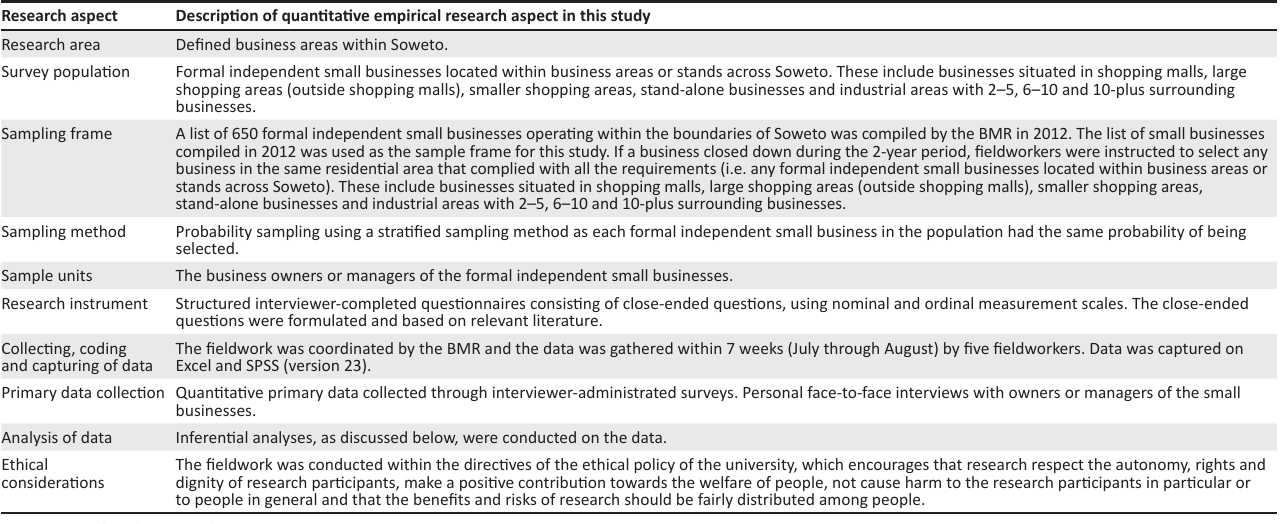
TABLE 1: Research methodology used to conduct the 2014 Soweto study. Research